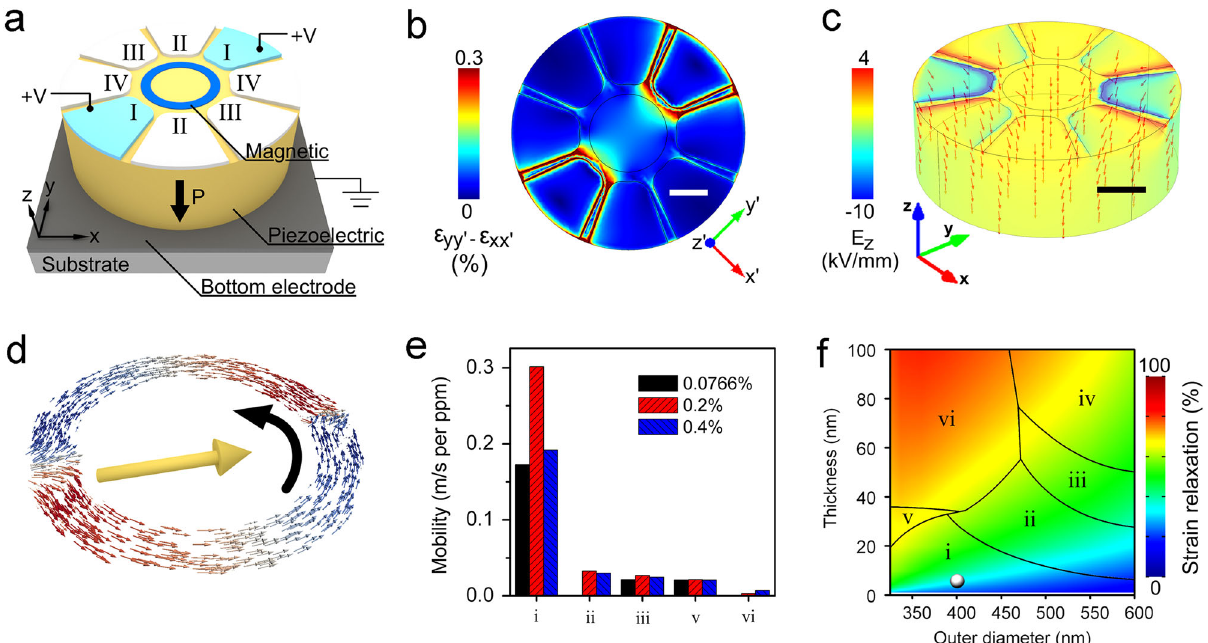
Fig. 8 a – c Optimizing the top electrodes structure (four pairs in total, see a ) for maximum surface piezostrain in the central circle region (marked in b , scale bar = 200 nm) in response to a driving voltage of 1.1 V, under the constraint that maximum local electric fi elds (see 3-D distribution in c , scale bar = 200 nm) would not exceed the dielectric breakdown fi eld. d – f Optimizing the domain-wall structure (see a transverse wall structure (type i) in d ) for maximum strain-controlled domain-wall mobility (results are summarized in e ) in a ring-shaped nanomagnet, under the constraints that the thermal stability is suf fi ciently high ( > 40) and that the degree of strain relaxation in the magnetic nano-ring is suf fi ciently low ( < 30%). The dimension of the nano-ring determines the con fi guration and the thermal stability of domain-wall structure, and the degree of strain relaxation as well, adapted with permission domain-walls in the ring magnet, a feature that has potential applications as magnetoelectric memories or motors. 154 Shown in Fig. 8d is a transverse-type magnetic domain-wall structure that possesses the highest strain-controlled magnetic domain-wall mobility (objective function) among all six different types of magnetic domain-wall structures (see Fig. 8e). As further shown in Fig. 8f, engineering the dimension of the ring magnet (design variable) can control the type of domain-wall structure. However, the following two design constraints, both of which are relevant to the ring dimension, need to be imposed during optimization. First, the degree of strain relaxation must be kept at a reasonable low value. Second, the thermal stability of the magnetic domain-wall structure must be suf fi ciently high.